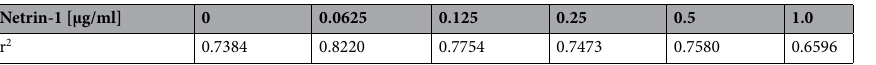
Table 1. The coefficient of determination (r 2 ) for the BMP4 response (pSmad1/5 level) against the LRIG1- FLAG expression levels at different netrin-1 concentrations as shown in Fig. 1g.